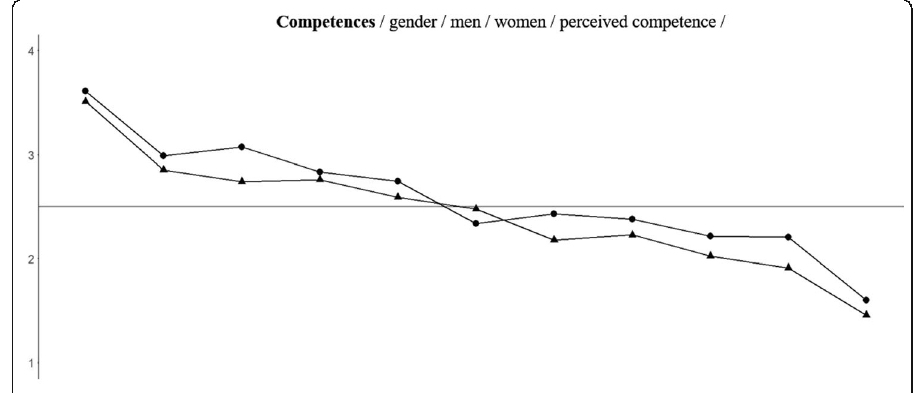
Fig. 1 Perceived competence in the search and treatment of information